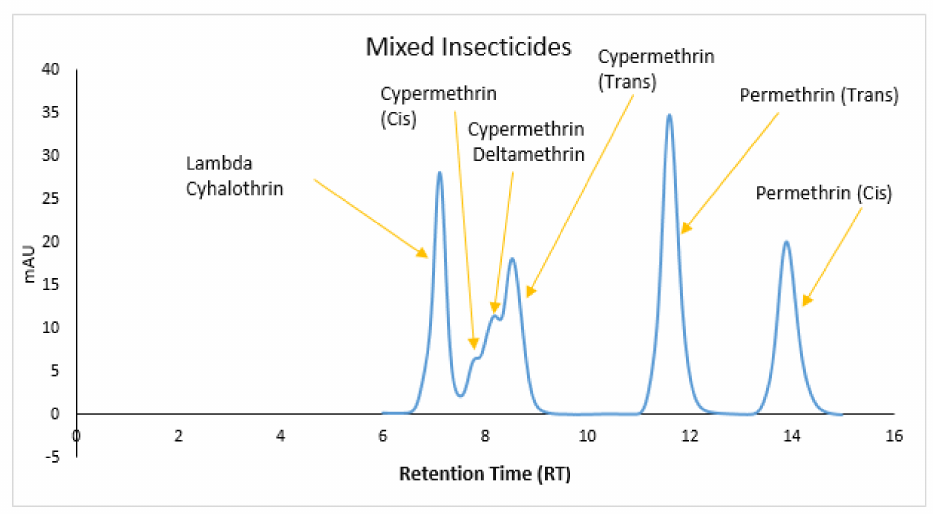
Figure 5. Retention times peaks of the active ingredients detected in soil